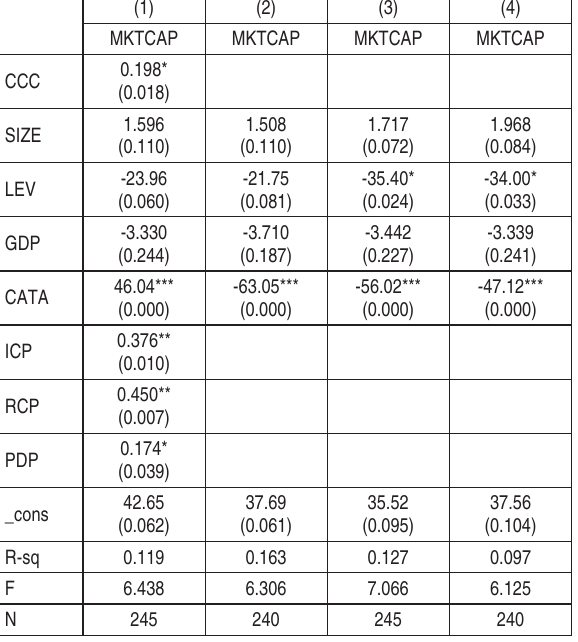
Table 5. OLS regression analysis of the relationship between firm value and WCM